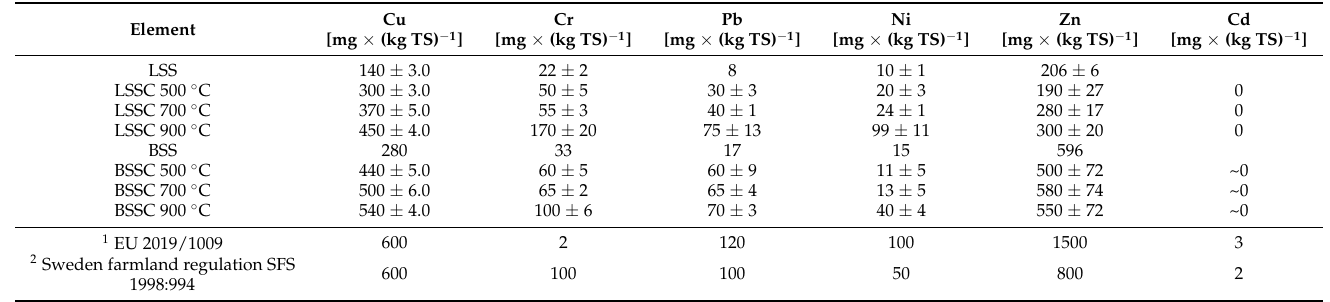
Table 5. The content of heavy metals in municipal sewage sludge (MSS) and sewage sludge chars (SSC) produced at various temperatures (500, 700, and 900 ◦ C) with standard deviations.